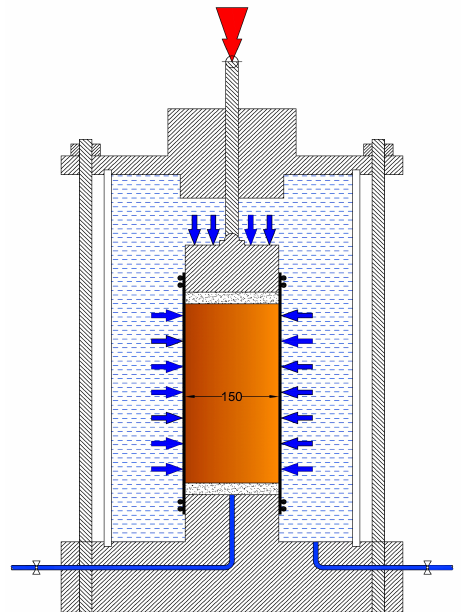
Figure 11. The basic principle and equipment for larger samples’ (d = 150 mm) triaxial test per- formance.